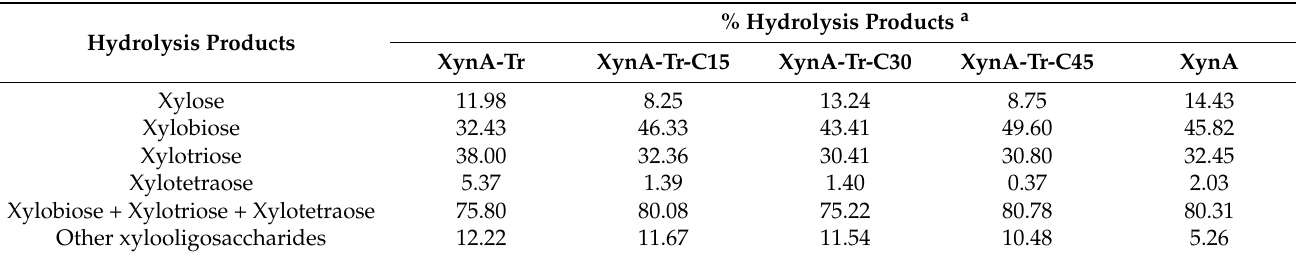
Table 2. Products of xylan degraded by five